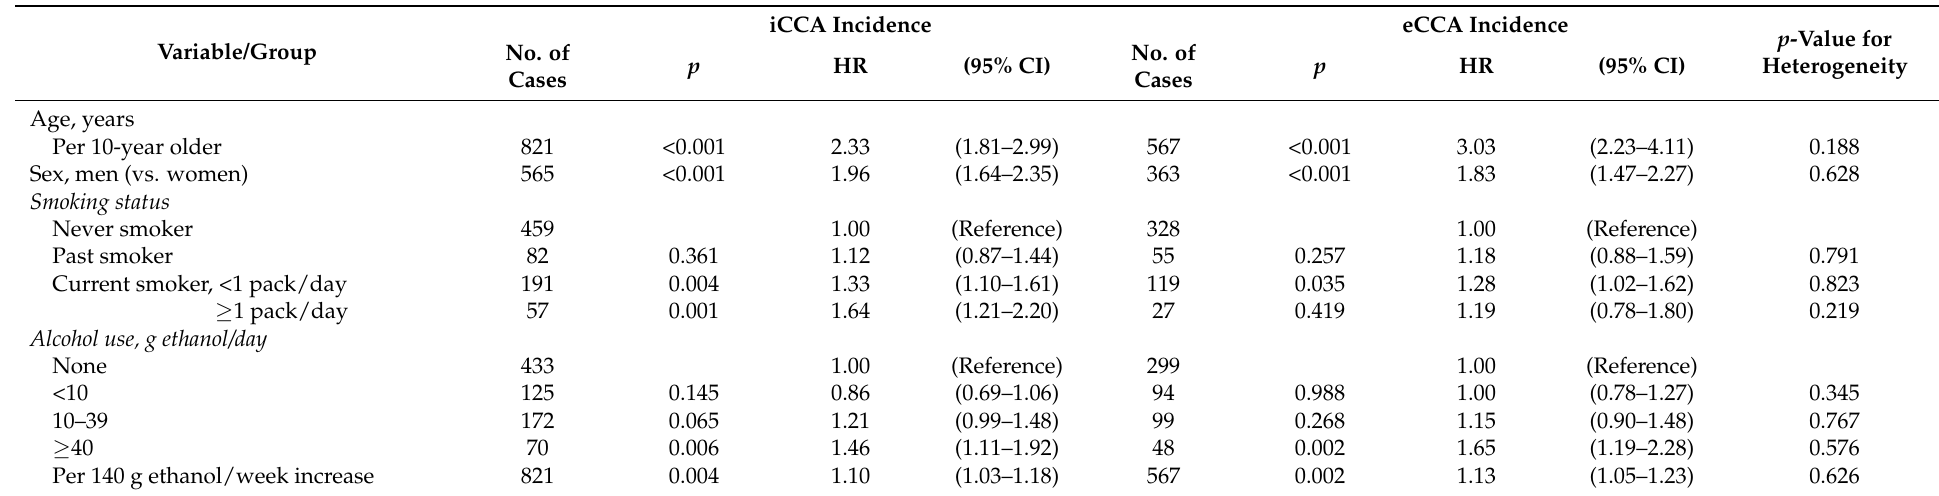
Table 3. Multivariable-adjusted HRs of iCCA and